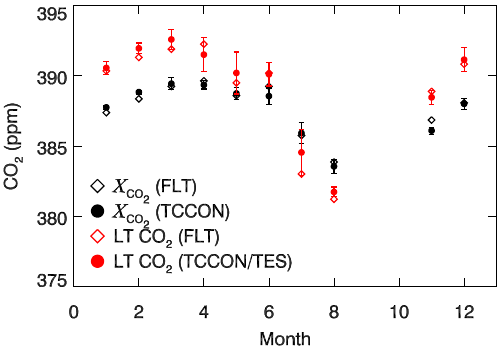
Fig. 8. Monthly mean X CO for total column and LT CO 2 in 2009 2 at Lamont. Aircraft data (FLT) are indicated by diamonds (black for total X CO ; red for LT CO 2 ) and TCCON or TCCON/TES esti- 2 mates are indicated by black or red dots with error